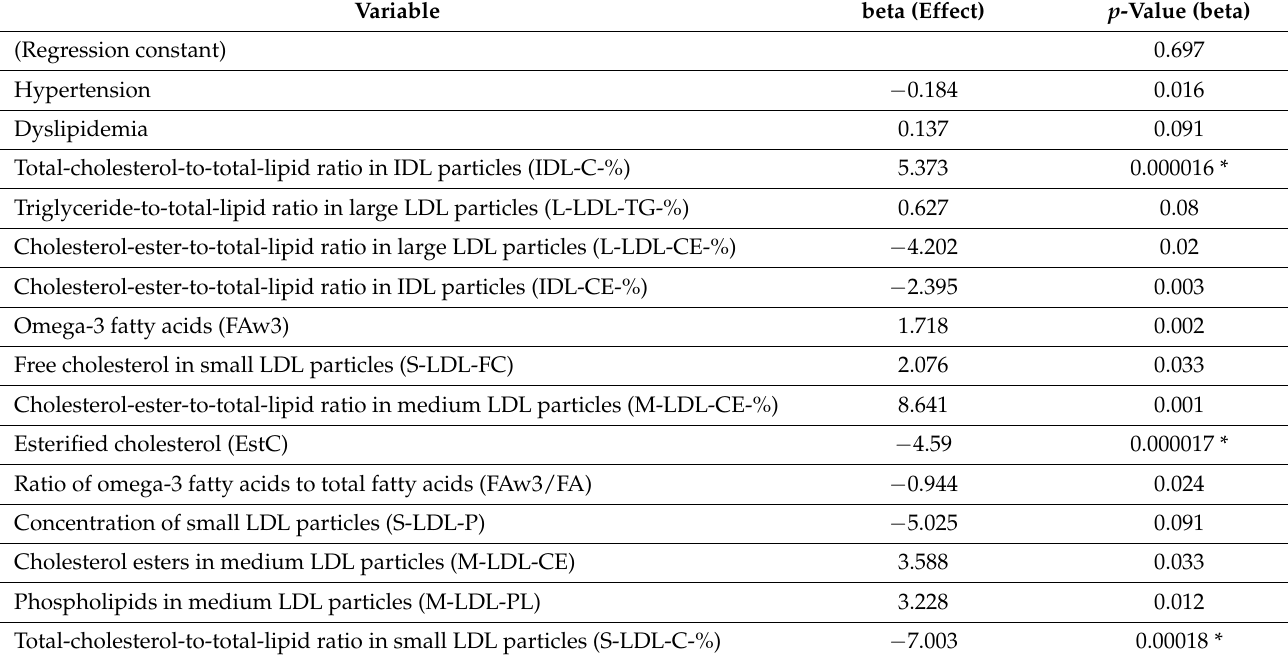
Table 3. Adjusted backward regression analysis of plasma NMR features, clinical, and demographics associated with the APOE dosage.